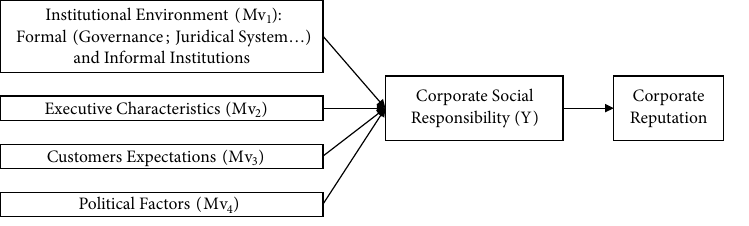
Figure 2. The theoretical